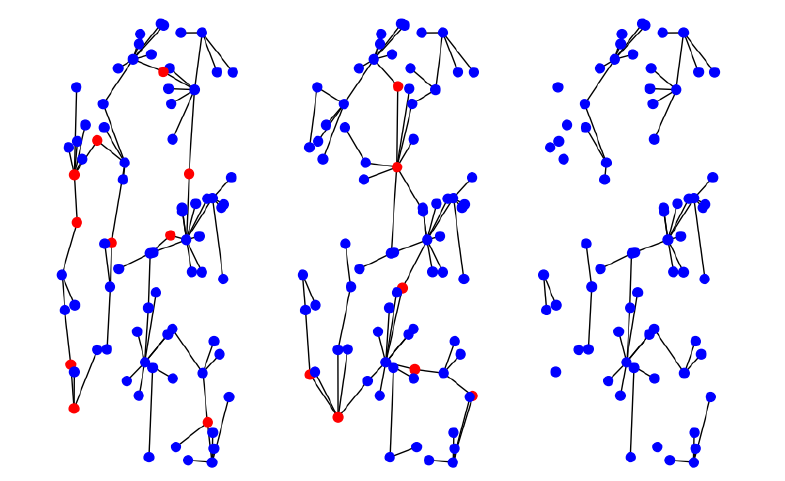
Figure 11. Example of an invalid crossover. The right graph is the result of a crossover between the two left graphs without applying randomConnect